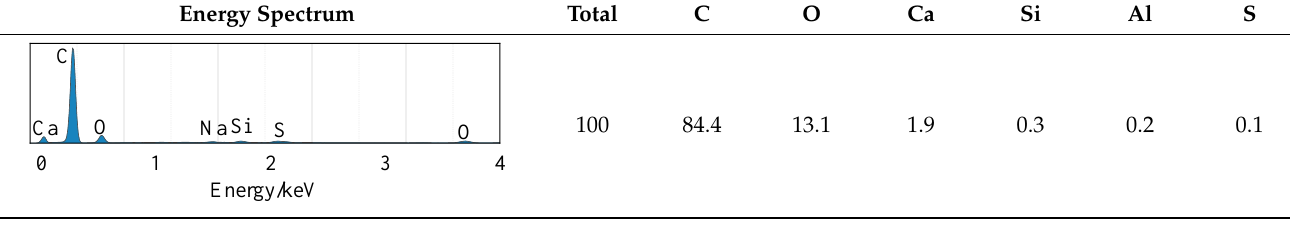
Figure 3. ( a ) Wastewater; ( b ) 8000 times magnified photo of wastewater particles. C-S-H = calcium